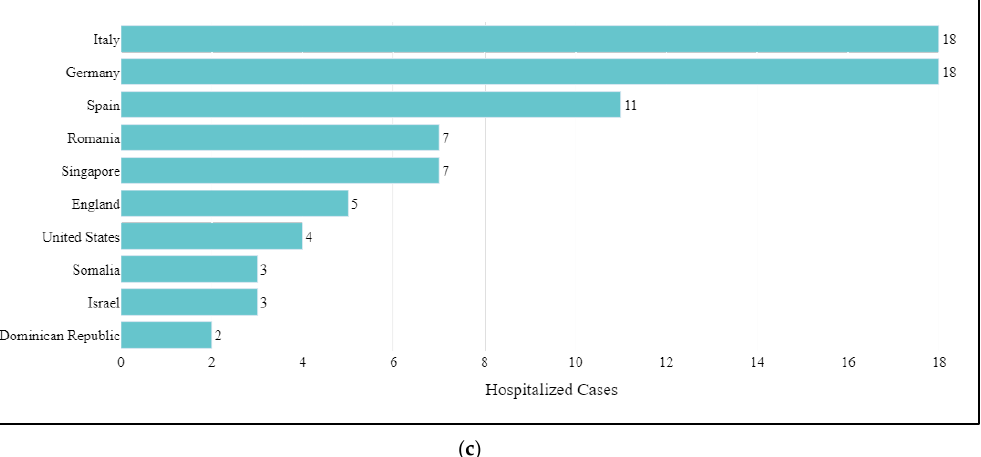
Figure 6. Top 10 countries according to the ( a ) confirmed cases, ( b ) suspected cases, and ( c ) hospitalized cases.